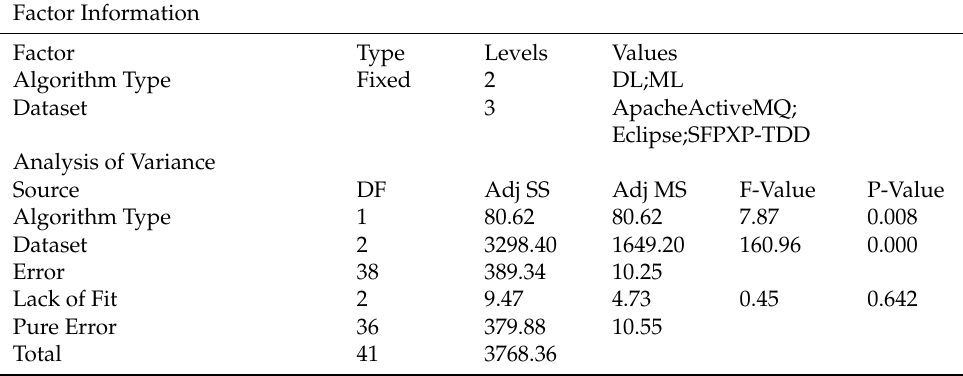
Table 13. Overall Evaluation of Experimental Results based on ACC.